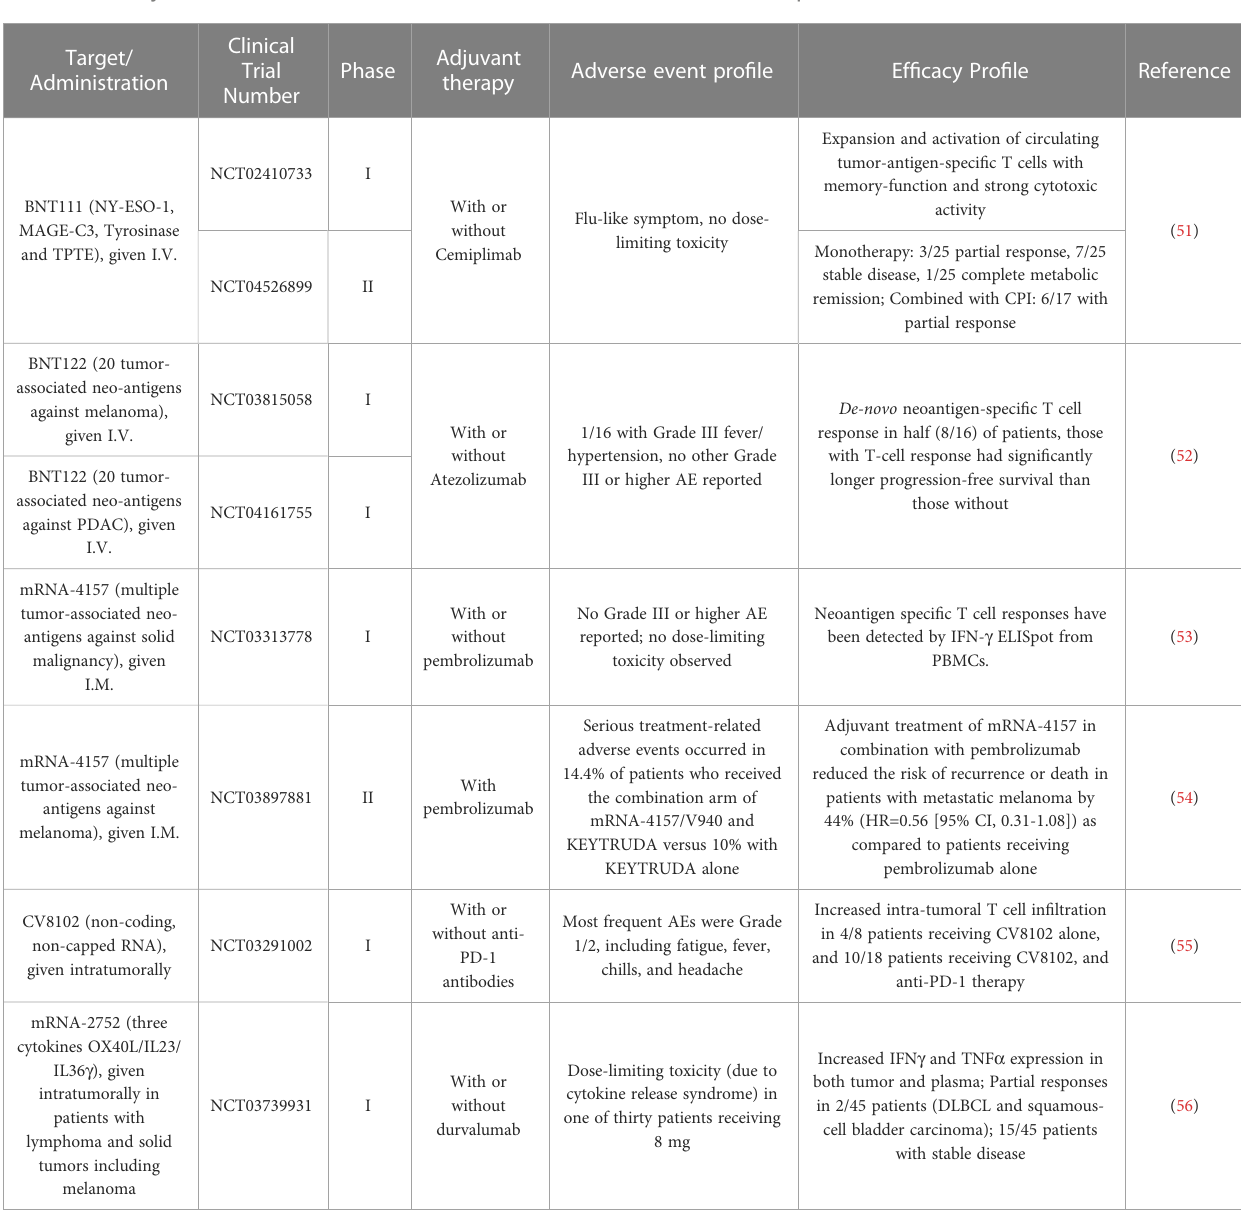
TABLE 1 Summary of the recent clinical trial data with mRNA melanoma